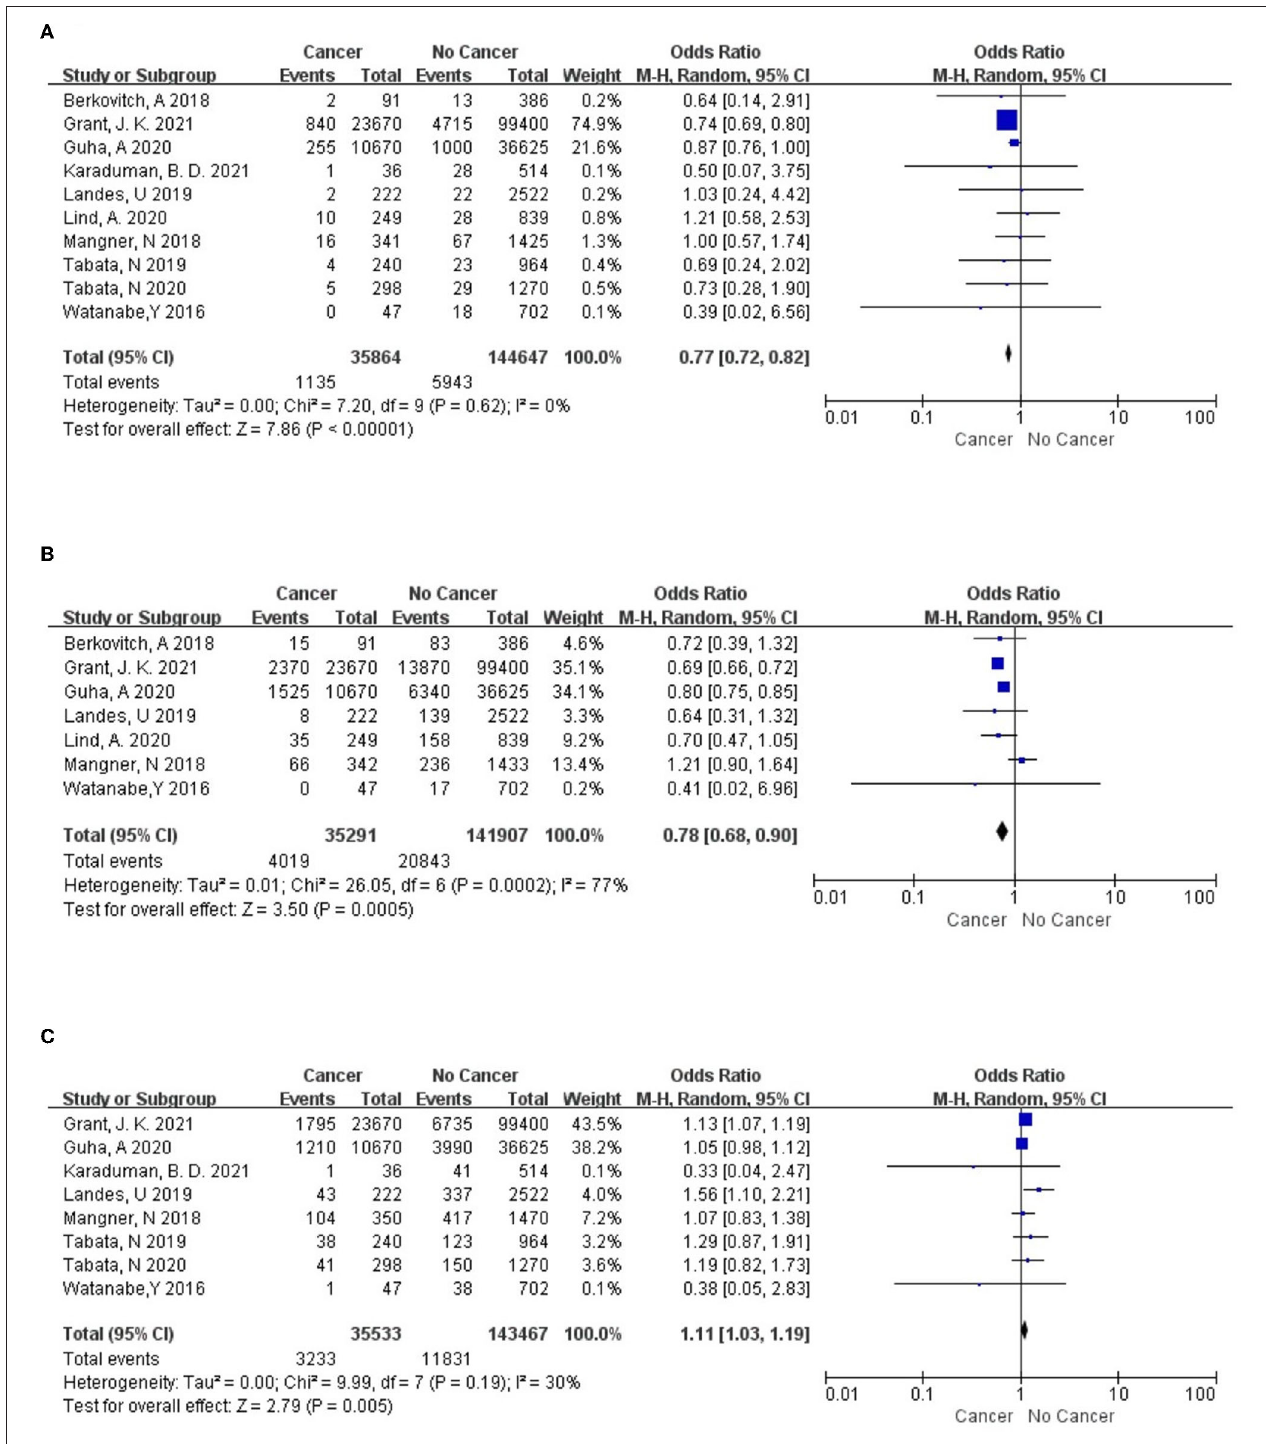
FIGURE 3 | The forest plots of (A) stroke, (B) AKI and (C) new permanent pacemaker.